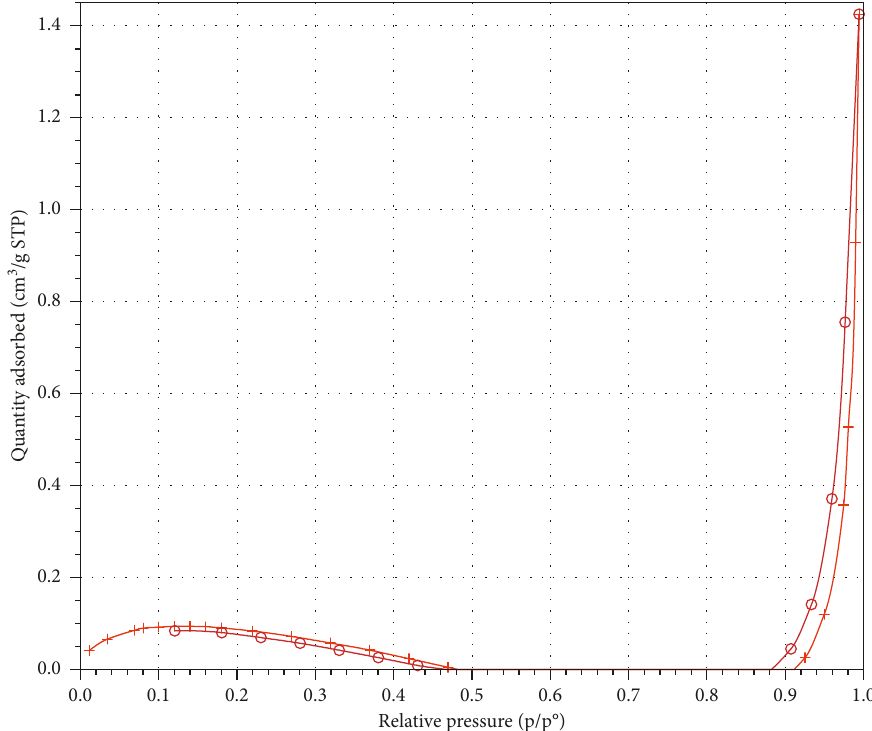
Figure 3: Nitrogen adsorption-desorption isotherm of